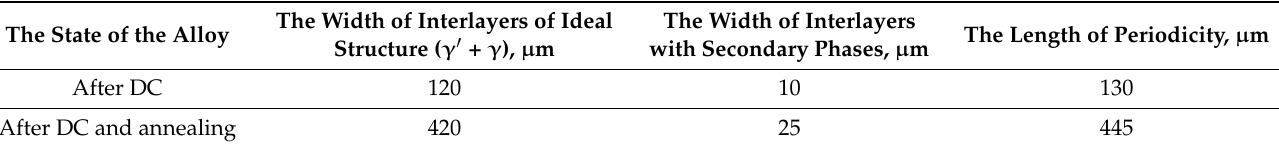
Table 4. Quantitative data of the periodicity of the structure of the superalloy. The Width of Interlayers of Ideal The Width of Interlayers The State of the Alloy The Length of Periodicity, µ m Structure ( γ (cid:48) + γ ), µ m with Secondary Phases, µ m After DC 120 10 130 After DC and annealing 420 25